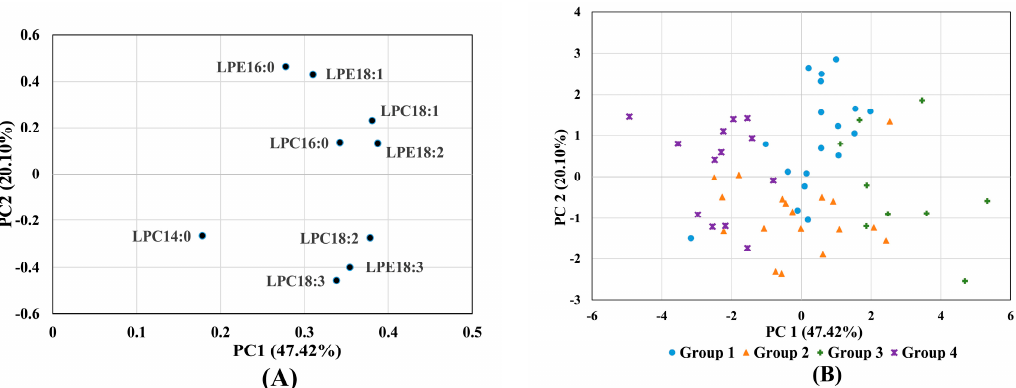
Figure 3. Results from principal components analysis (PCA) of LPL data with ( A ) loadings for each LPL and ( B ) scores for each cultivar plotted for the first two PCA components.